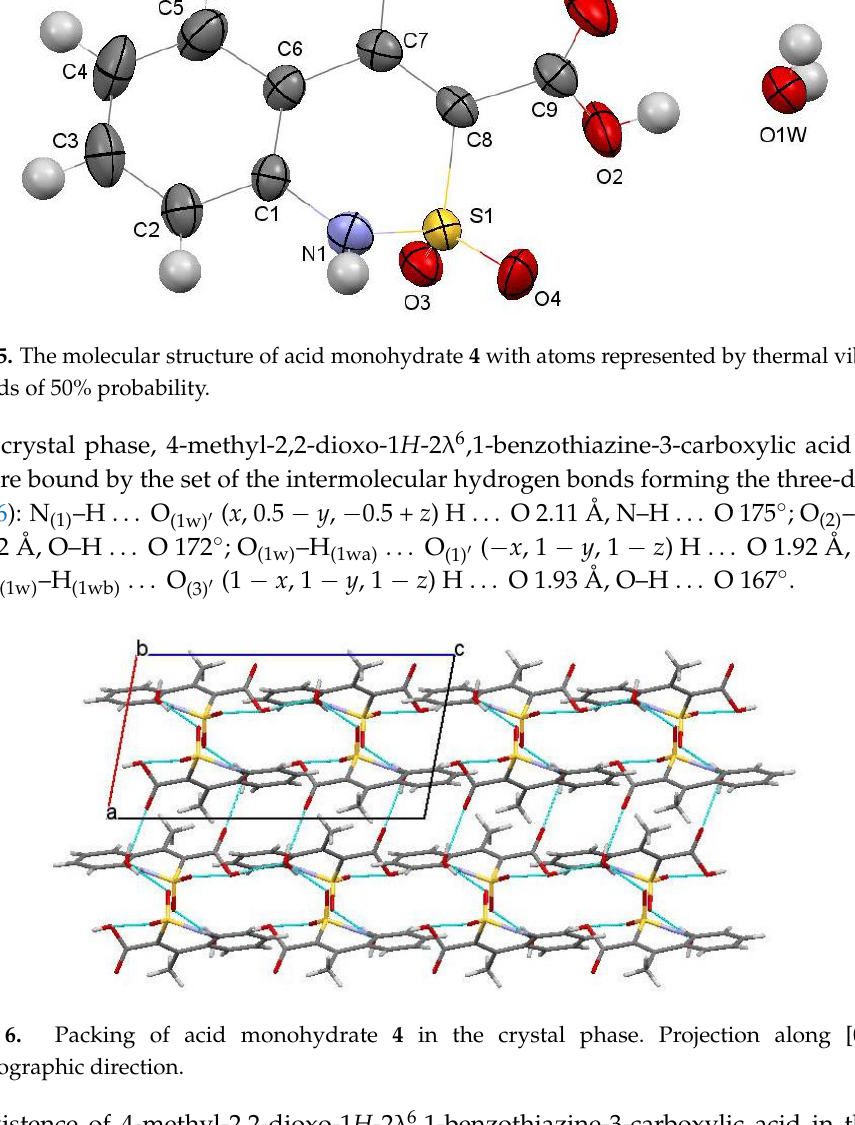
Figure 6. Packing of acid monohydrate 4 in the crystal phase. Projection along [0 1 0] crystallographic direction.